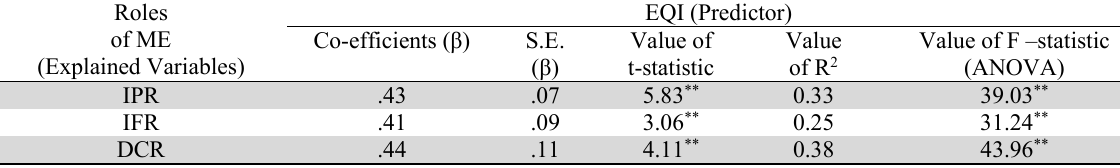
Summary of Regression Analysis regarding EQI and Roles of ME Roles (Explained